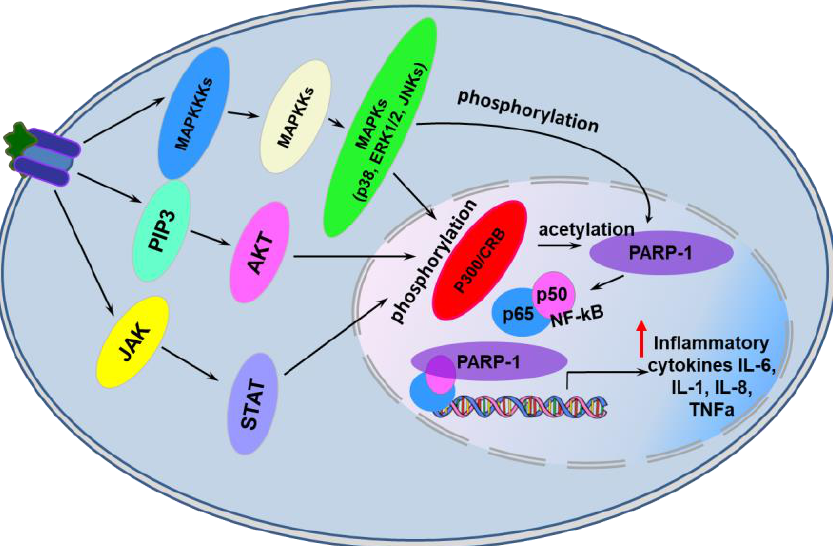
Figure 3. PARP-1-dependent transcriptional activation of genes encoding pro-inflammatory cytokines in eukaryotic cells. See text for details. Abbreviations: JAK—Janus kinase; PIP3—phosphatidylinositol (3,4,5)-trisphosphate; MAPKKKs—Mitogen-Activated Protein (MAP) kinase kinase kinases; MAPKKs—Mitogen-activated protein kinase kinases; MAPKs—mitogen-activated protein kinases; STAT—members of the signal transducer and activator of transcription protein family; AKT—subfamily of serine/threonine kinases; p38—p38 mitogen-activated protein kinases; JNK—c-Jun N-terminal kinases; ERKs—extracellular signal-regulated kinases; IL-l, IL6, IL-8—interleukins 1, 6, 8, p300/CRB—p300/CREB-binding protein complex, TNF α —tumor necrosis factor α